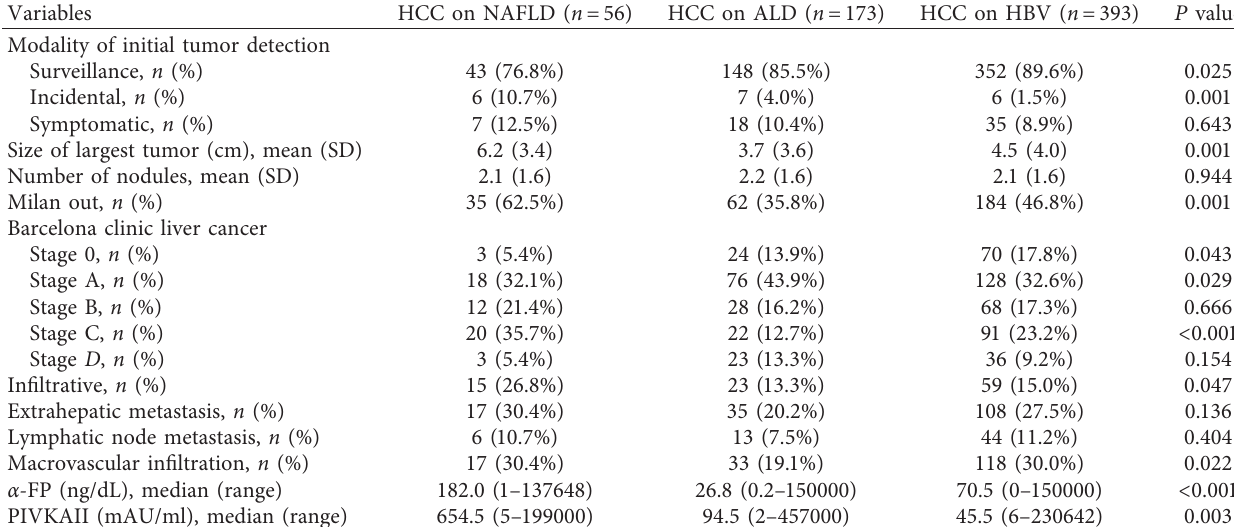
Table 2: Tumor characteristics of